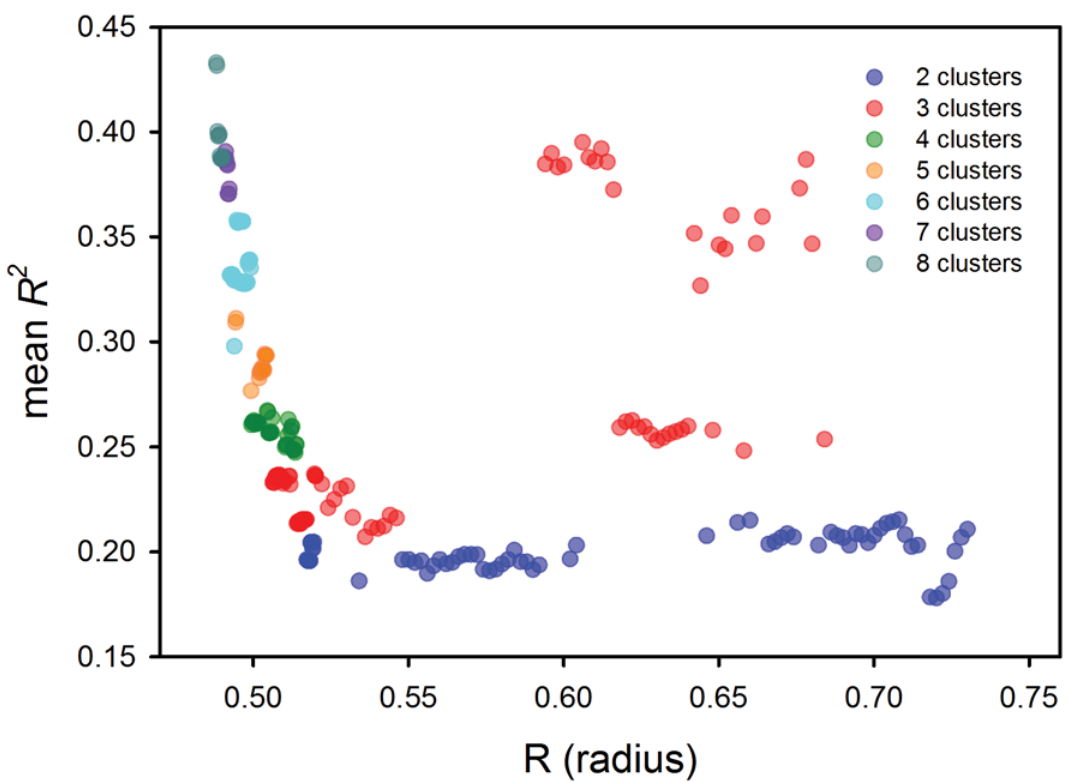
Figure 1. Model fit (mean R 2 scores) of candidate models developed to represent fire-weather seasons. Candidate models were generated by varying a parameter describing the radius used in the algorithm of the nonparametric cluster analyses. Models shown here were developed using four daily fire- weather variables (not wind speed) over 13 years (1997 –